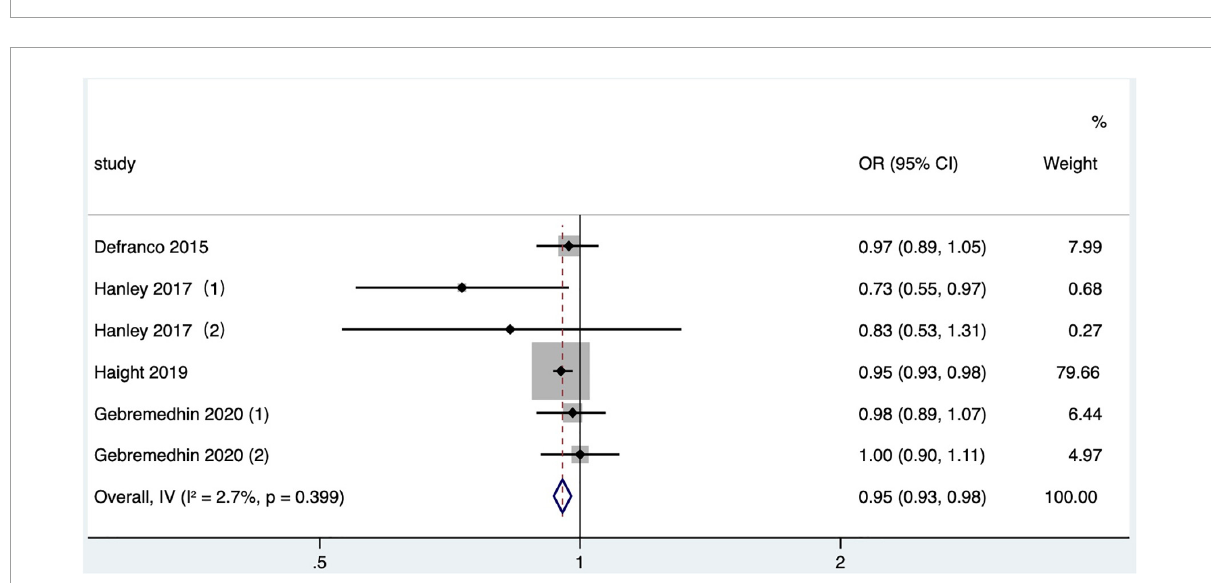
FIGURE12 Meta-analysis forest map of the effect of short IPI on gestational hypertension. Hanley et al. (36) (1) was non-matching data, and Hanley et al. (36) (2) was within-mother matching data; Gebremedhin et al. (46) (1) was non-matching data, and Gebremedhin et al. (46) (2) was within-mother matching